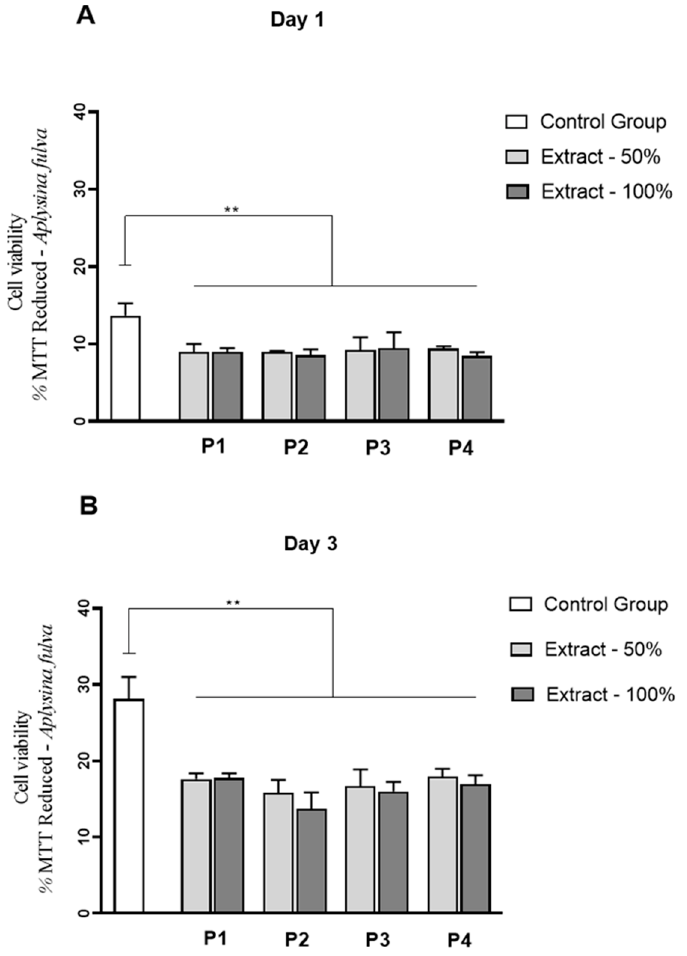
Figure 11. Viability L929 cell line by MTT assays for A. fulva protocols extracts at experimental periods of 1 day ( A ) and 3 days ( B ) of L929 culture. ** p < 0.0001 (Anova/Tukey test).